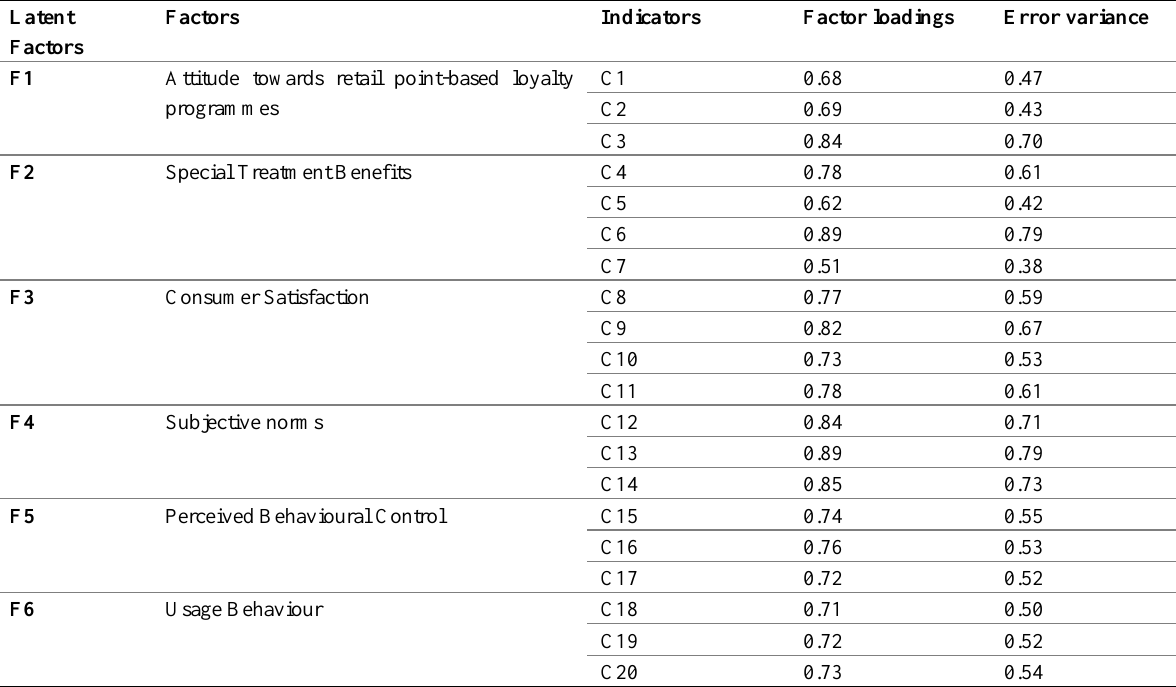
Table 5: Standardised coefficients of the measurement